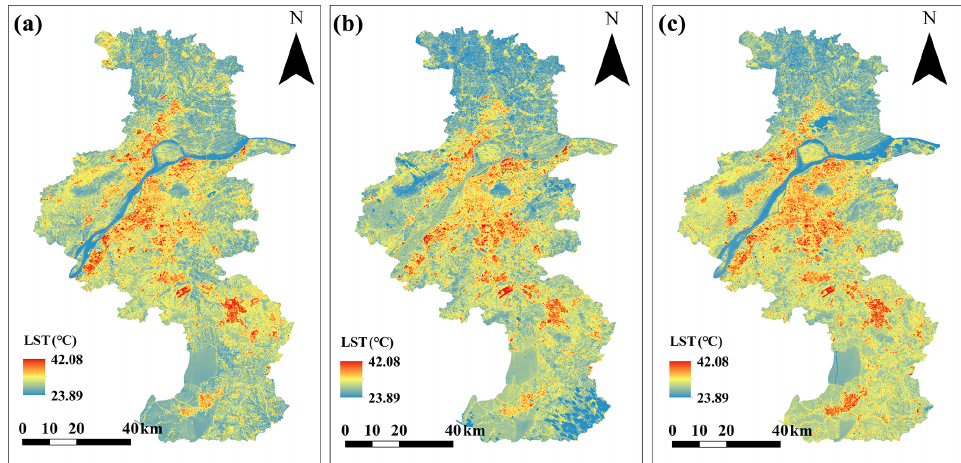
Figure 9. Spatial distribution of the LST in Nanjing: (a) 11 August 2013; (b) 2 September 2015; (c) 21 July 2017.